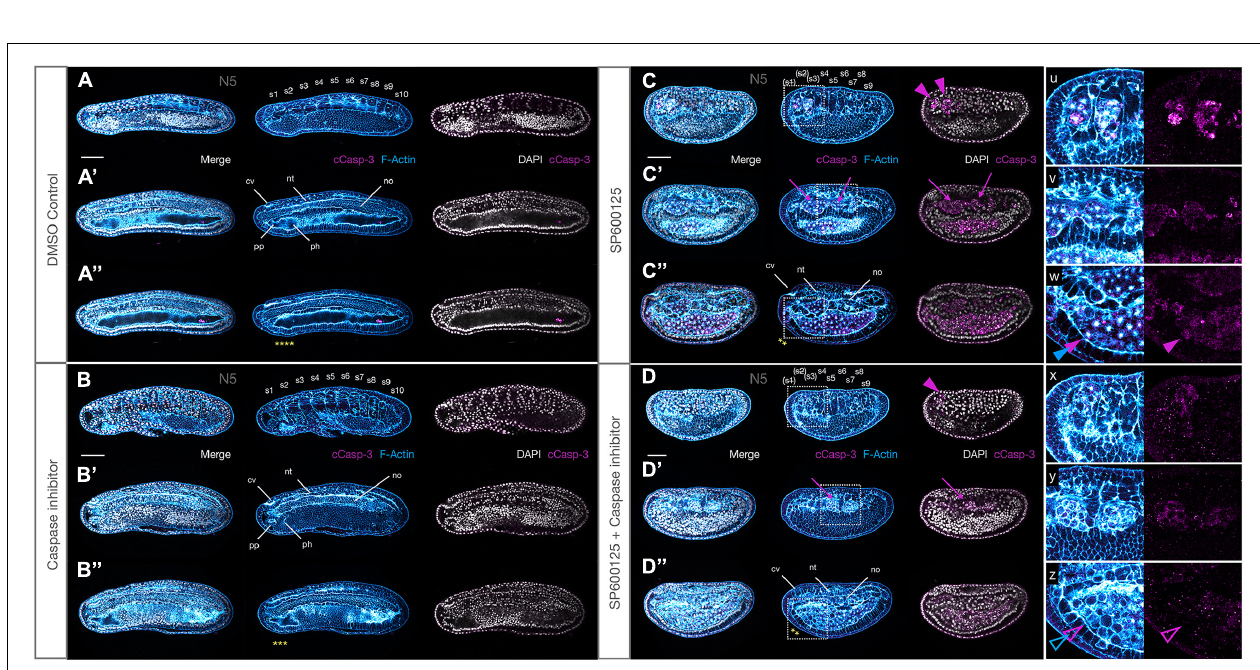
FIGURE 9 | A pan-Caspase inhibitor only partially rescues weak JNK inhibition phenotypes. (A,A (cid:48) ,A (cid:48)(cid:48) ) N5 stage DMSO control with 10 somite pairs (A) , a preoral pit (A (cid:48) ) , and expanding pharyngeal region ( A (cid:48)(cid:48) , yellow asterisks). (B,B (cid:48) ,B (cid:48)(cid:48) ) Stage matched embryo treated with the pan-Caspase inhibitor Z-VAD-fmk at high concentration (200 µ M). Embryos are slightly shorter but otherwise equivalent to the controls, with all differentiated structures present. (C,C (cid:48) ,C (cid:48)(cid:48) ) Weak JNK inhibition with 2.5 µ M SP600125 shows dramatic accumulation of cleaved Caspase-3 in dying cells, including degenerating anterior somites ( C , s1–s3, magenta arrowheads; inset u), cells extruded around the notochord ( C (cid:48) , magenta arrows, inset v), and within the archenteron ( C (cid:48) , inset w). No real pharyngeal region has differentiated (yellow asterisks). (D,D (cid:48) ,D (cid:48)(cid:48) ) Embryos co-treated with SP600125 and Z-VAD-fmk are grossly similar to embryos treated with SP600125 alone. However, cleaved Caspase-3 immunoreactivity is significantly reduced both quantitatively and qualitatively. The notochord, although still delayed, has a more regular cellular arrangement (compare C (cid:48)(cid:48) ,D (cid:48)(cid:48) ), and cellular protrusions (insets x and y) contain rounded cells, but fewer central F-Actin aggregates. Rounded cells in the anterior of the archenteron have a similar “healthier” phenotype (compare w and z, filled and outlined blue and magenta arrowheads), with evidence that at least some may originate from within the anterior ventral endoderm layer. Phalloidin staining of F-Actin is in blue and cleaved Caspase-3 (cCasp-3) immunoreactivity is in magenta, while DAPI stained nuclei are in grey. Embryos are orientated with anterior to the left and dorsal up. Each panel series shows one representative embryo at different confocal planes. cv, cerebral vesicle; nt, neural tube; no, notochord; s1, s2, etc., somite pairs. Scale bars = 50 µ M.